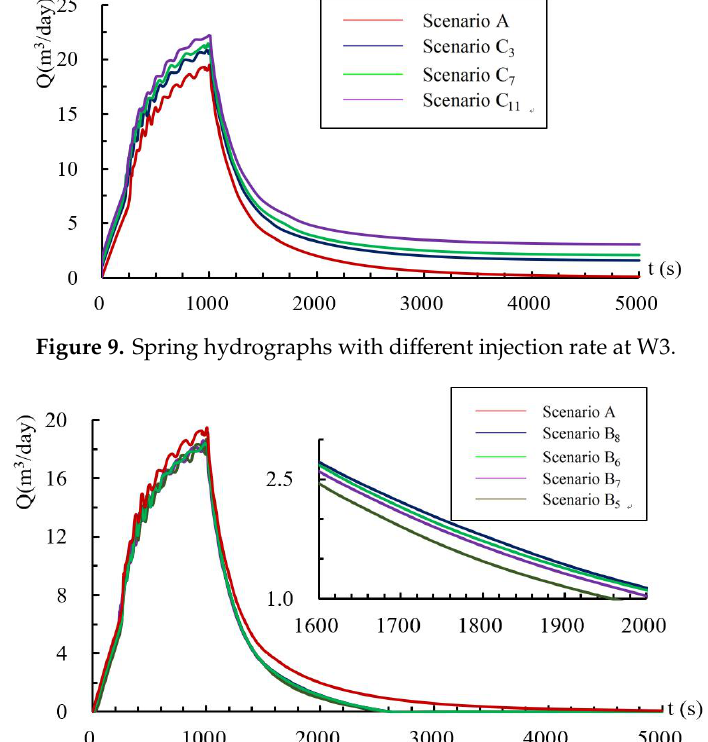
Figure 10. Spring hydrographs with pumping at different wells.